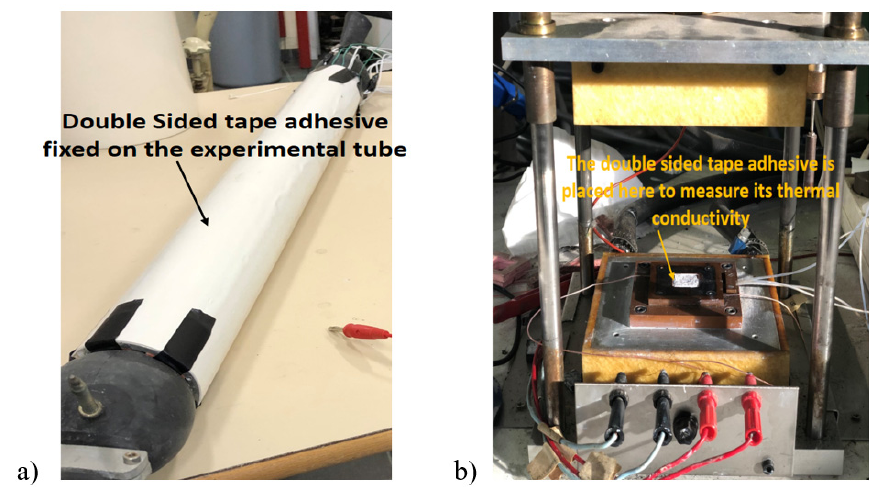
Figure 8. Double adhesive tape on ( a ) experimental tube ( b ) hot guarded plate.